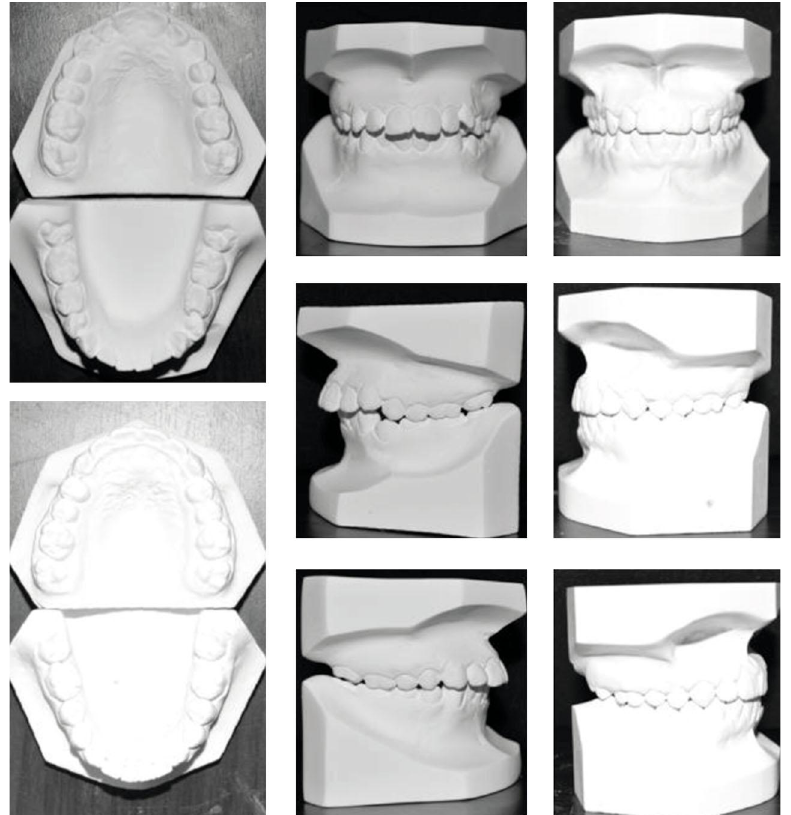
Figure 20: Initial and fi nal study